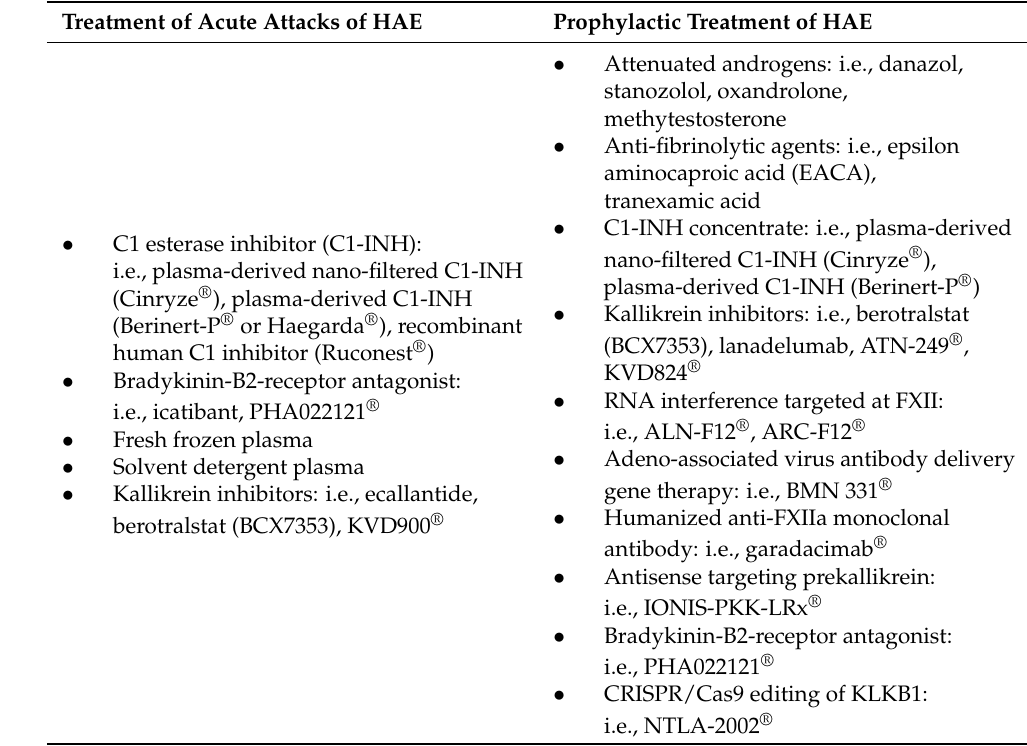
Table 2. Pre-specified possible network intervention nodes for HAE